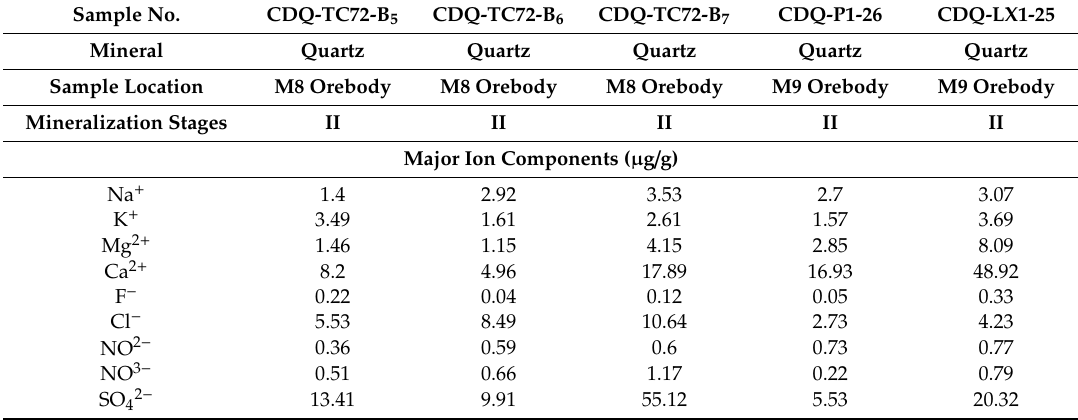
Table 2. The results of the ion chromatography analysis of the fluid inclusions exist in quartz from the Chuduoqu Pb-Zn-Cu deposit.